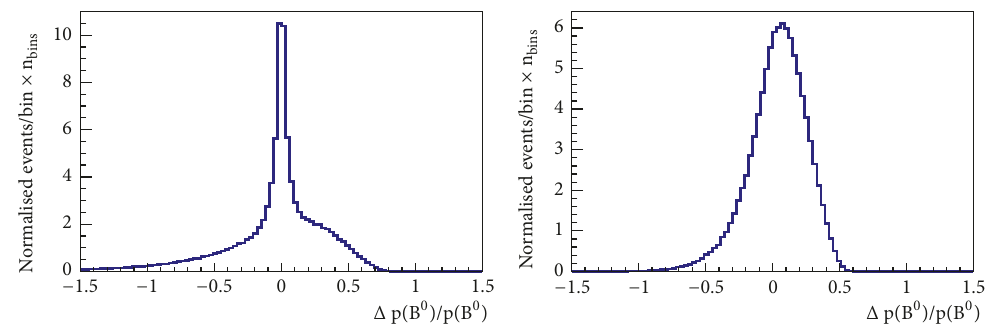
Figure 4. Their distributions are wider than those resulting from the full reconstruction algorithm, since less information on the decay is